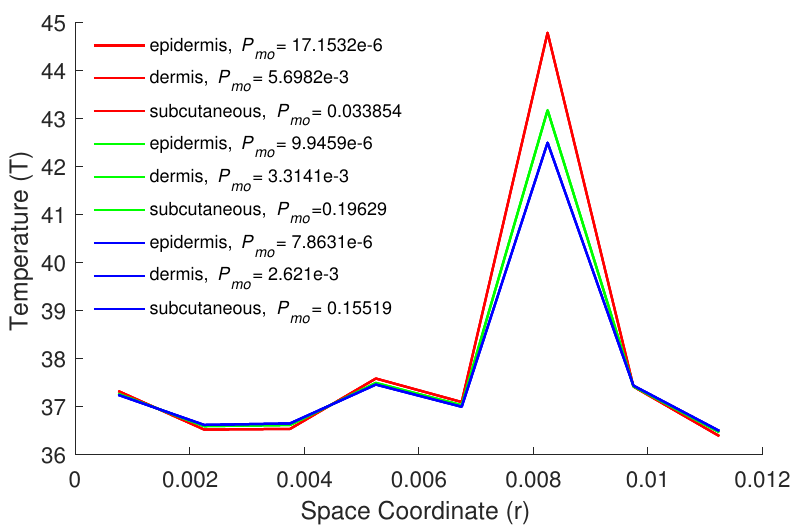
Figure 8. Temperature distributions for different values of P mo in first kind B.C.